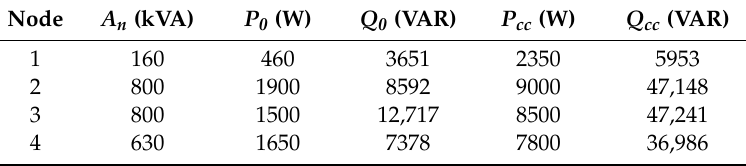
Table 3. Rated data of the MV / LV transformers powered by